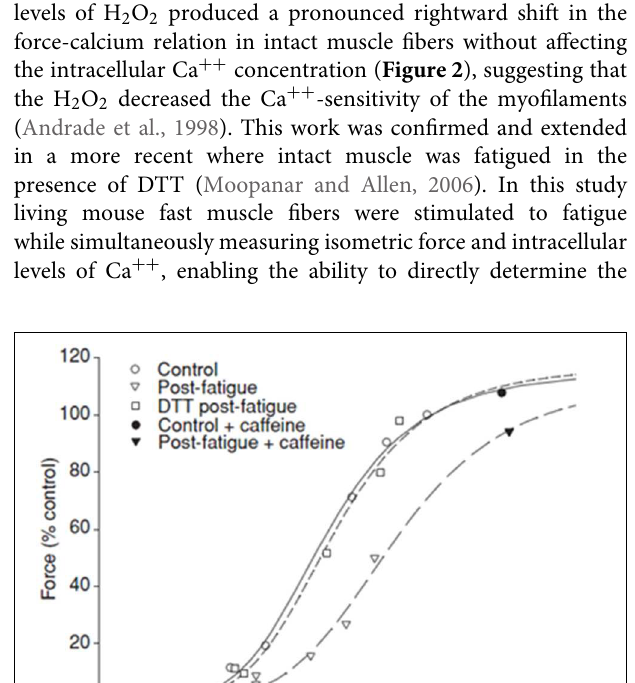
Frontiers in Physiology |